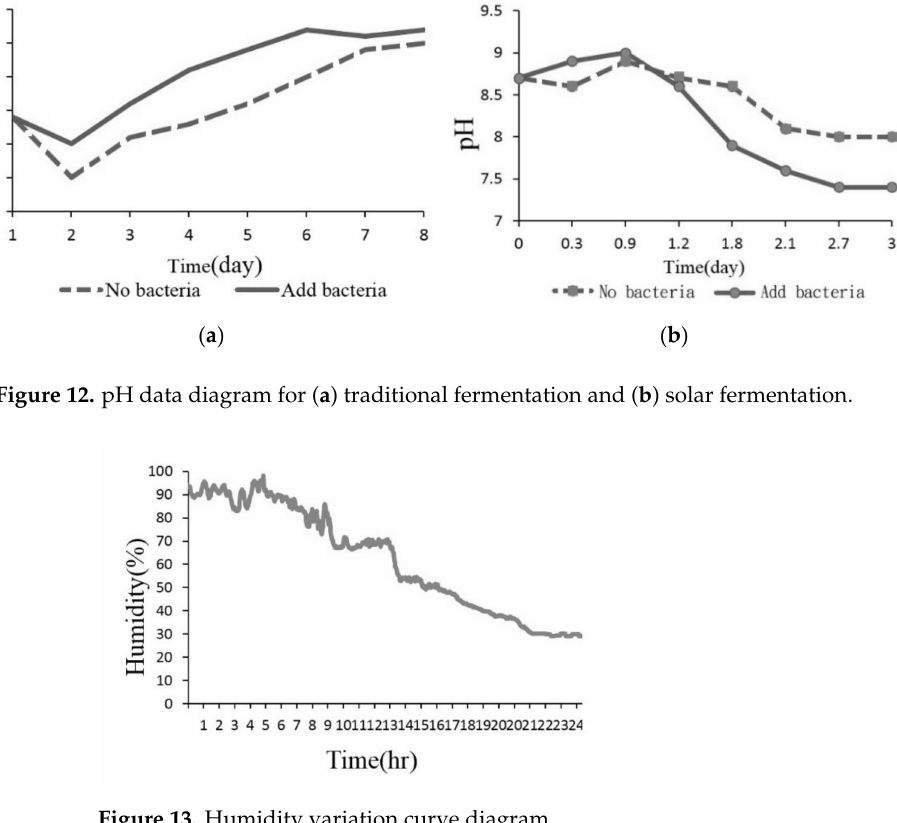
Figure 13. Humidity variation curve